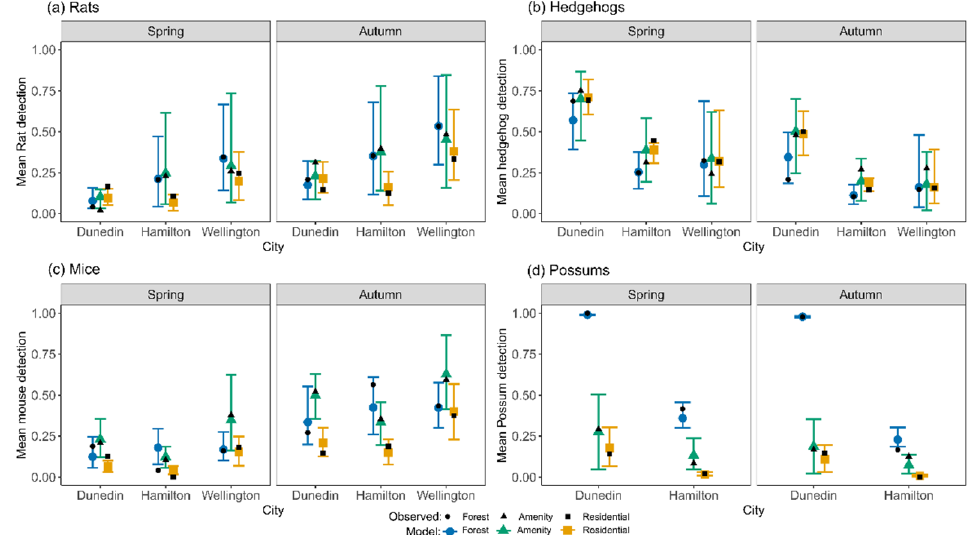
Figure 2. Detection probability of mammalian predators across city and habitat type, split by season, for ( a ) rats, ( b ) hedgehogs, ( c ) mice, and ( d ) possums. Black symbols represent observed mean detection rate; coloured symbols are mean estimated probability of detection based on predictions of the main model. Bars represent 90% credible intervals. Fitted probabilities for each sampling location (from the posterior distribution) were averaged within each season, city, and habitat type and across devices (i.e., 12 possible detections per line from 10 stations and two cameras). Possums were detected in Wellington only once in spring (mean detection = 0.001) and were not